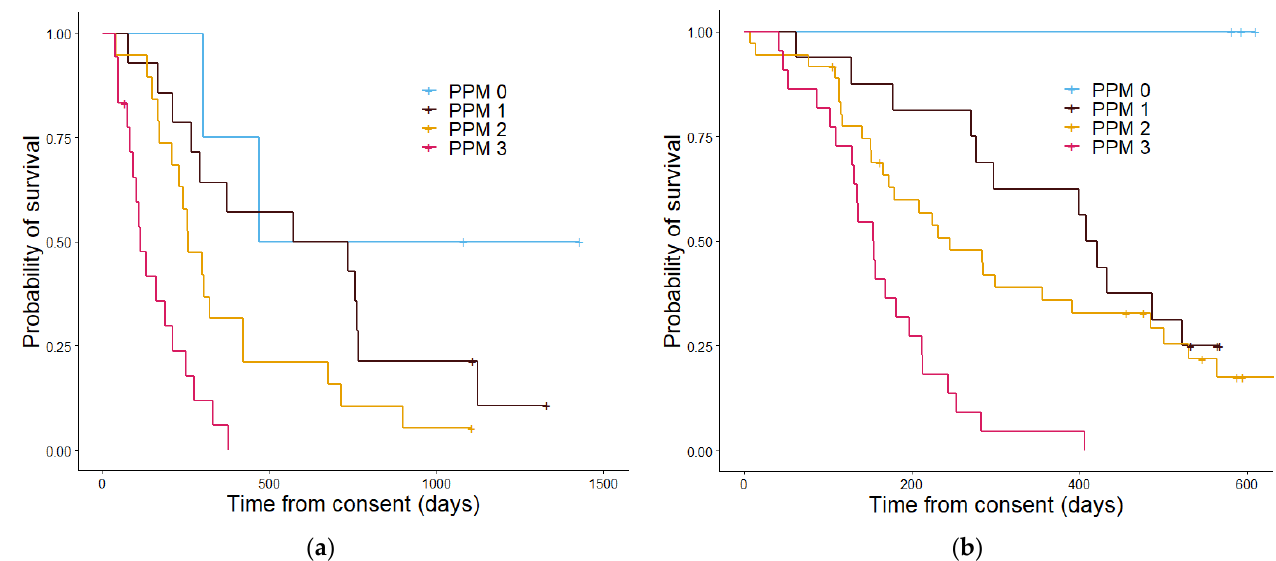
Figure 6. Kaplan–Meier curves showing the overall survival determined by the Proteomics Score in the discovery cohort ( a ) and the validation cohort ( b ). In the discovery cohort ( a ) patients with a PPM score of 0 had a median estimated overall survival in days of 467, patients with a PPM score of 1 had a median overall survival of 612 days, patients with a PPM score of 2 had an estimated median overall survival of 229 days, and patients with a PPM score of 3 had median overall survival of 148 days. The p value was 4.42 × 10 − 6 . In the validation cohort ( b ) the median overall survival estimate in days for PPM score 0 could not be calculated as all patients in this group were alive, for PPM score 1 the median overall survival in days was 407, patients with a PPM score 2 had an estimated median overall survival of 283 days and those with a PPM score 3 had an median overall survival of 153 days. The p value was 7.4 × 10 − 7 .